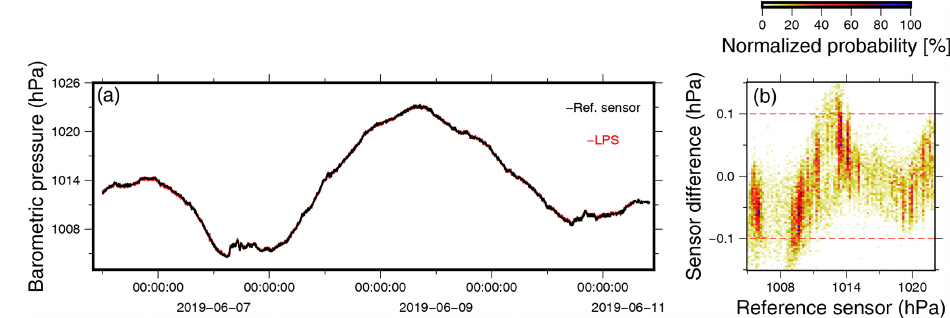
Figure 5. A comparison between the barometric MEMS sensor (red) and a KNMI reference barometer (black). Panel (a) shows 5d of barometric pressure recordings using both sensors, while panel (b) displays the difference in measured barometric pressure by the MEMS and the reference sensor.